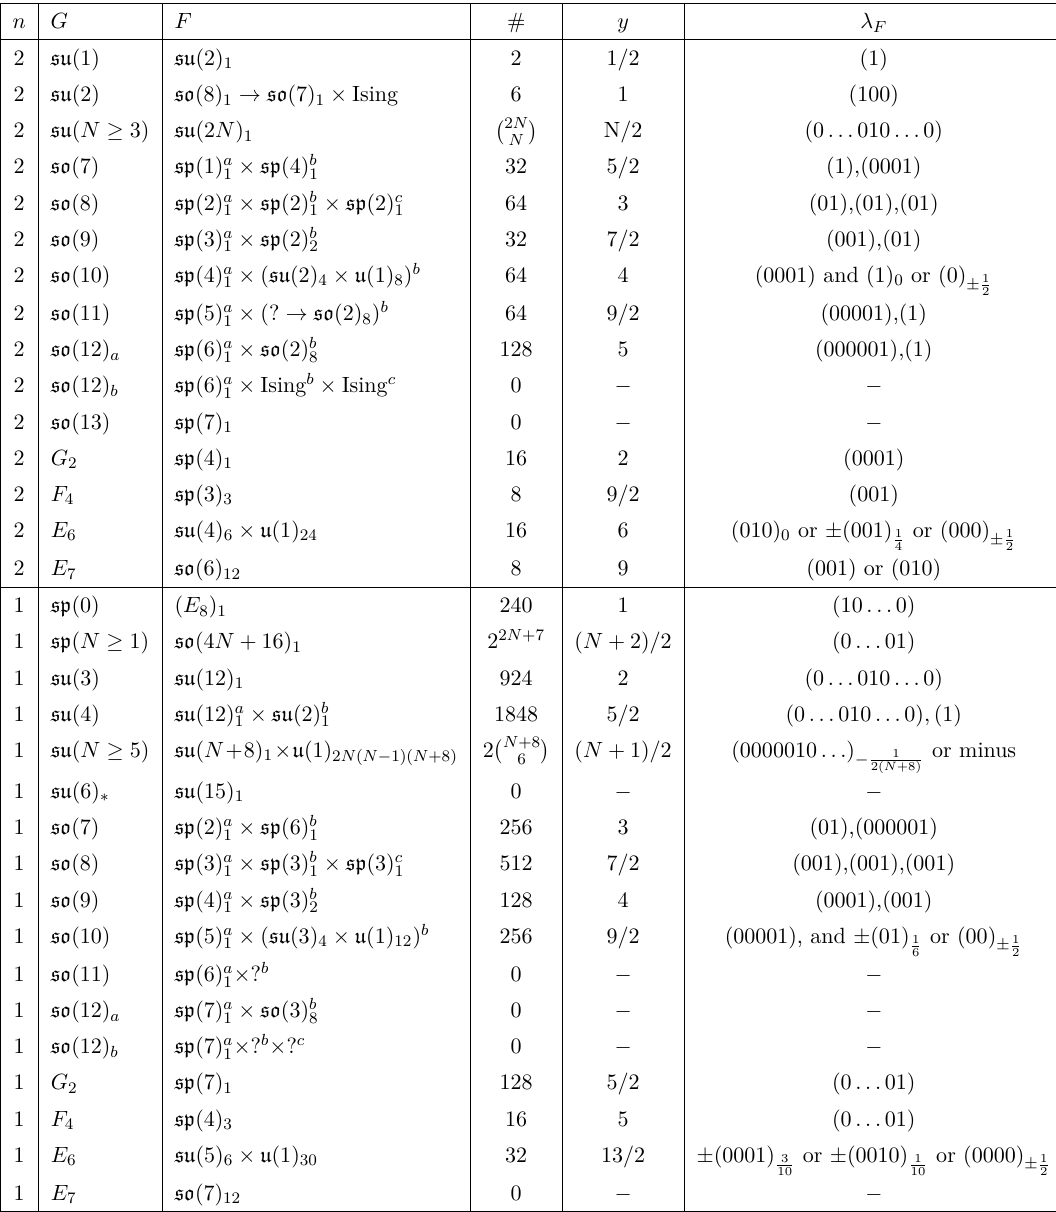
Table 6 . The parameters y, λ F of unity blowup equations for rank one models with n = 1 , 2 . # is the number of unity equations with fixed characteristic a